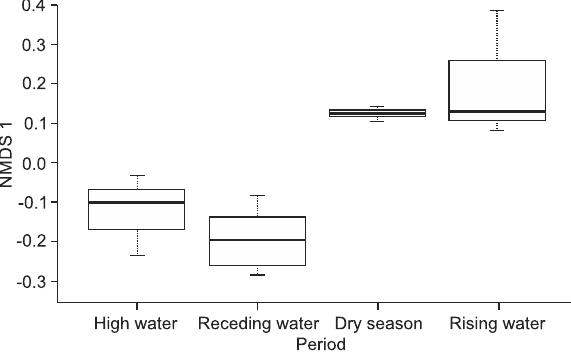
Figure 3. Variation in the number of spider families based on the Sorensen index in canopies of Vochysia divergens throughout the different seasonal periods in the northern region of the Pantanal of Mato Grosso,